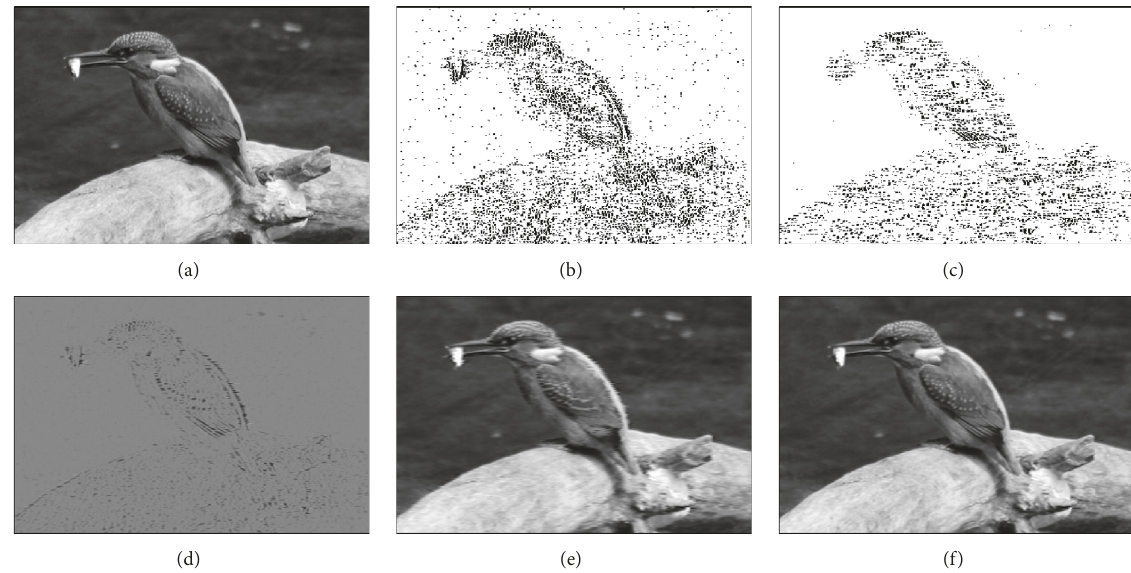
Figure 3: Decomposition (a), component extraction and representation of high frequency component ( 𝜆 ∈ [0,0.1] ) (b), medium frequency component ( 𝜆 ∈ [0.5, 0.7] ) (c), high and medium frequency component ( 𝜆 < 1 ) (d), low frequency component ( 𝜆 = 1 ) (e), and recomposition of all components (f).